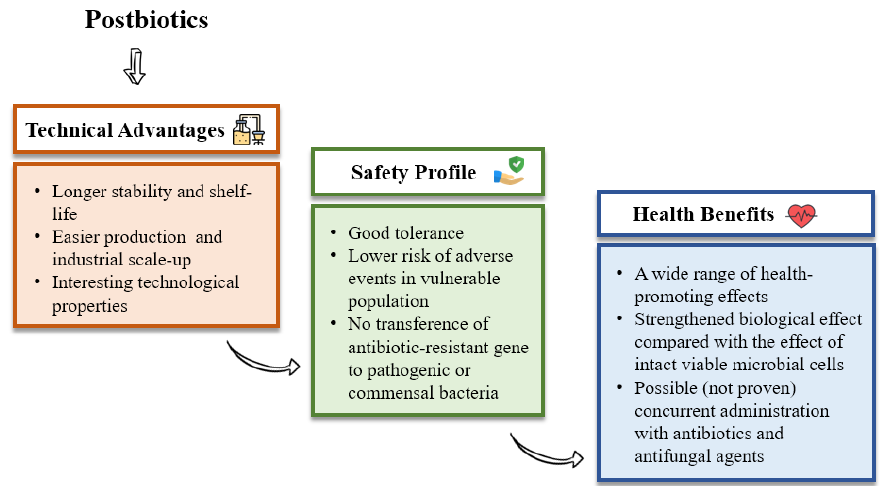
Figure 2. General characteristics of postbiotics.